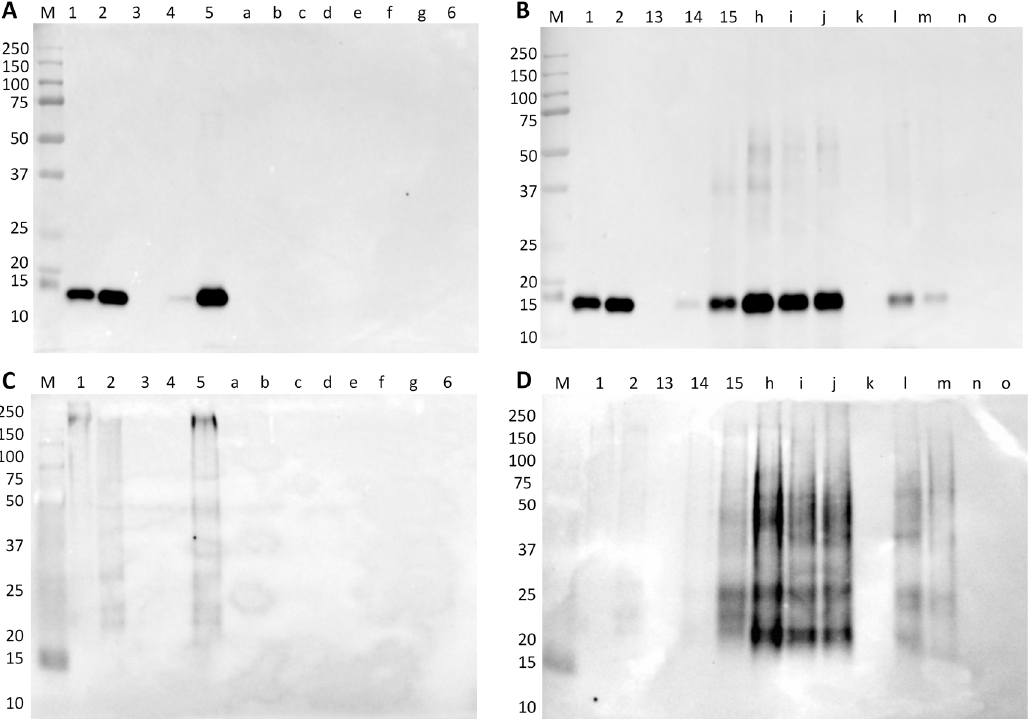
Figure 5. Immunoblot membranes for soybean testing using anti-trypsin inhibitor polyclonal antibody in denaturing ( A , B ) and native conditions ( C , D ) with hams ( A , C ) and sausages ( B , D ) commercial and in-house-made samples. Legend: lane 1, SPI; lane 2, SPC; lane 3, model pork cooked ham (0%